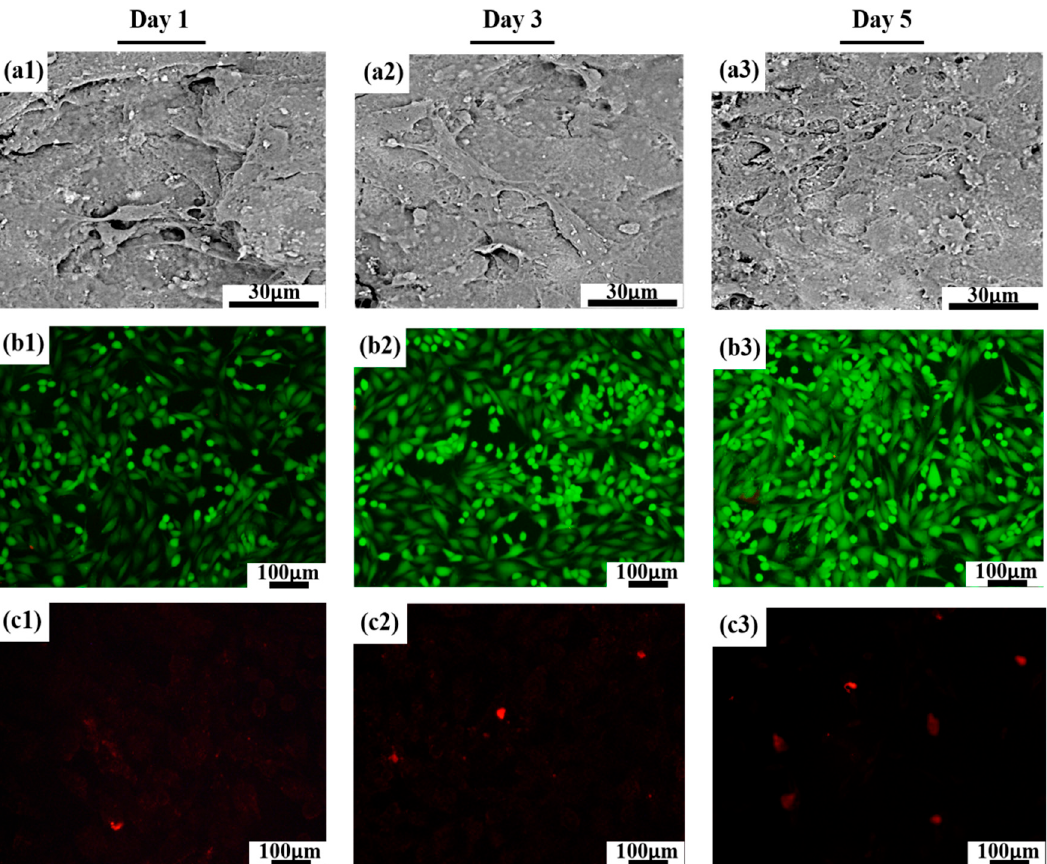
Figure 8. Adhesion morphology of MG-63 cells cultured on the PLLA/20% C-HAP scaffold for ( a1 ) 1 day, ( a2 ) 3 days, ( a3 ) 5 days; Fluorescence staining of live MG-63 cells after culturing on the PLLA/20% HAP scaffold for ( b1 ) 1 day, ( b2 ) 3 days, ( b3 ) 5 days; Fluorescence staining of dead MG-63 cells after culturing on the PLLA/20% C-HAP scaffold for ( c1 ) 1 day, ( c2 ) 3 days, ( c3 ) 5 days.